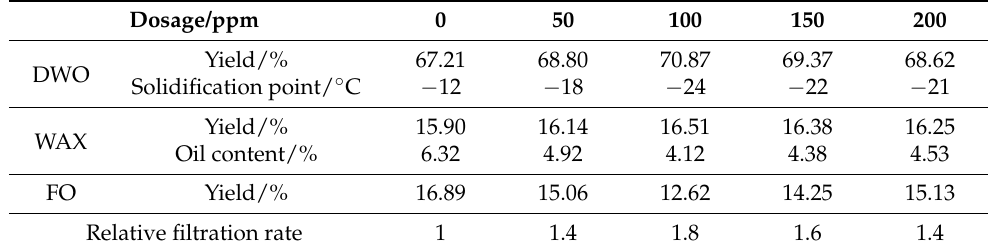
Table 6. MEK–toluene dewaxing with different dosages of AMAC.